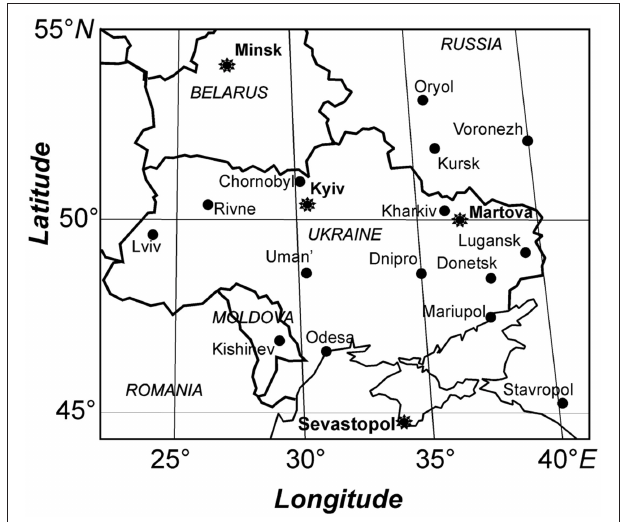
FIGURE 1 | Ukraine territory and other adjusted investigated regions for aerosol study discussed in the paper. The sun-photometer AERONET sites location is shown by